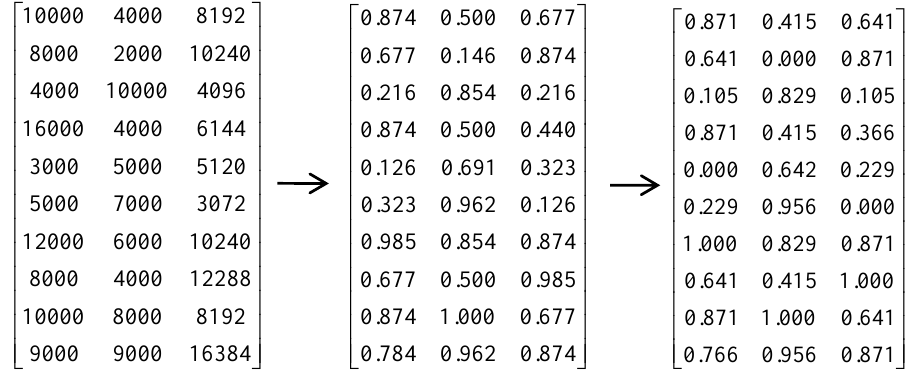
Fig 4. Process of data